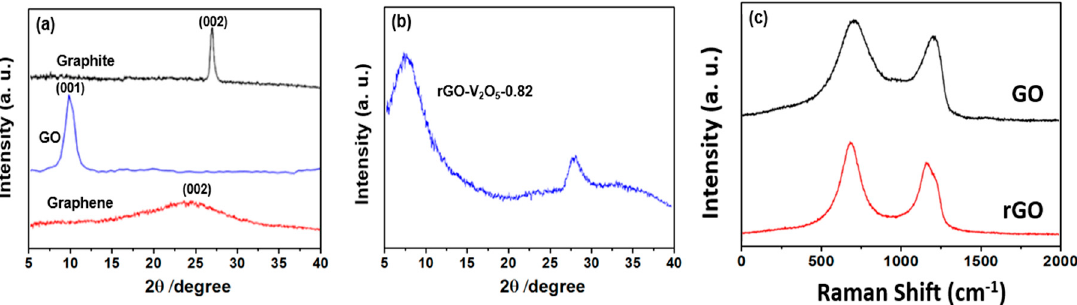
Figure 2. ( a , b ) XRD patterns of graphite, GO, graphene, and rGO-V 2 O 5 -0.82 hybrid aerogel; and ( c ) Raman spectra of GO and rGO.